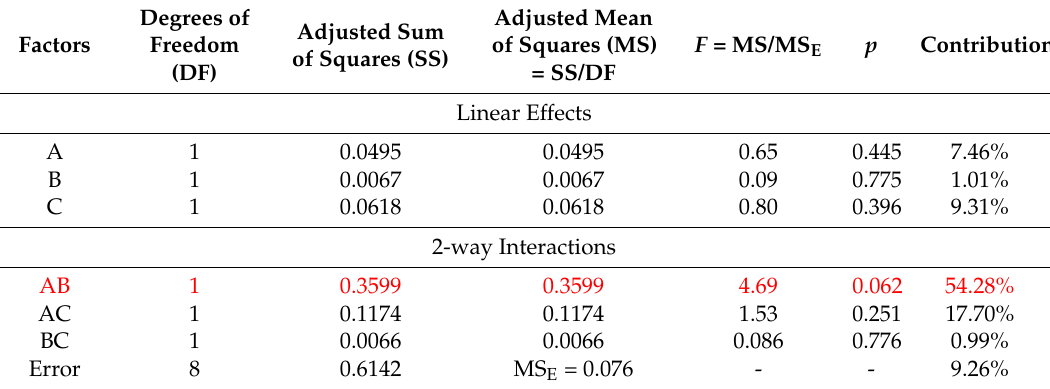
Table 3. Analysis of variance for I D / I G using adjusted SS (Sum of Squares) for the tests. The text marked in red represents the statistically-significant term.